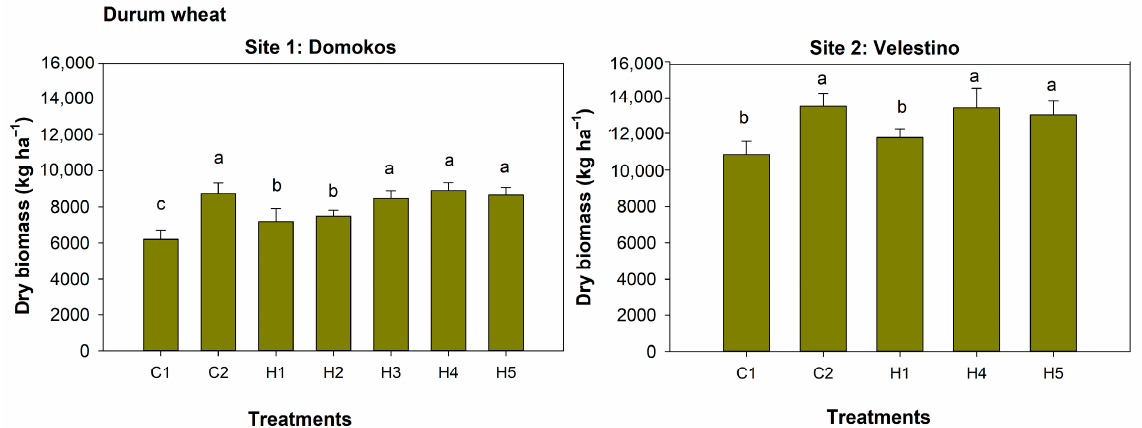
Figure 7. Herbicide treatment (C1: untreated control, C2: weed-free control, H1: metsulfuron-methyl + bensulfuron-methyl, H2: pyroxsulam/florasulam + 2,4-D, H3: aminopyralid + florasulam, H4: bromoxynil + 2,4-D, and H5: halauxifen-methyl + florasulam) effects on dry weight (kg ha − 1 ) at two sites. Values are presented as means of three replicates ± standard deviation. Mean values followed by different letters have statistically significant differences according to Duncan’s multiple range test at p < 0.05. F values of ANOA: F = 11.354 *** (Site 1: Domokos) and F = 10.114 ** (Site 2: Velestino). ** and *** significant at p < 0.01 and p < 0.001.